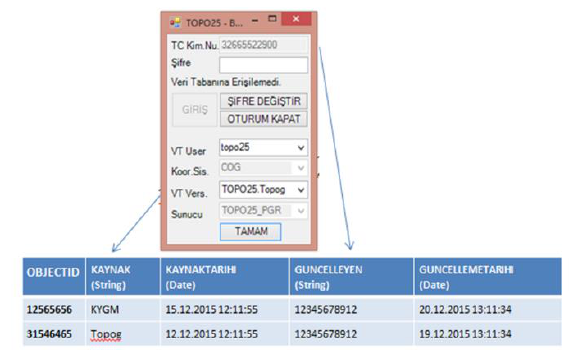
Figure 8. Feature based